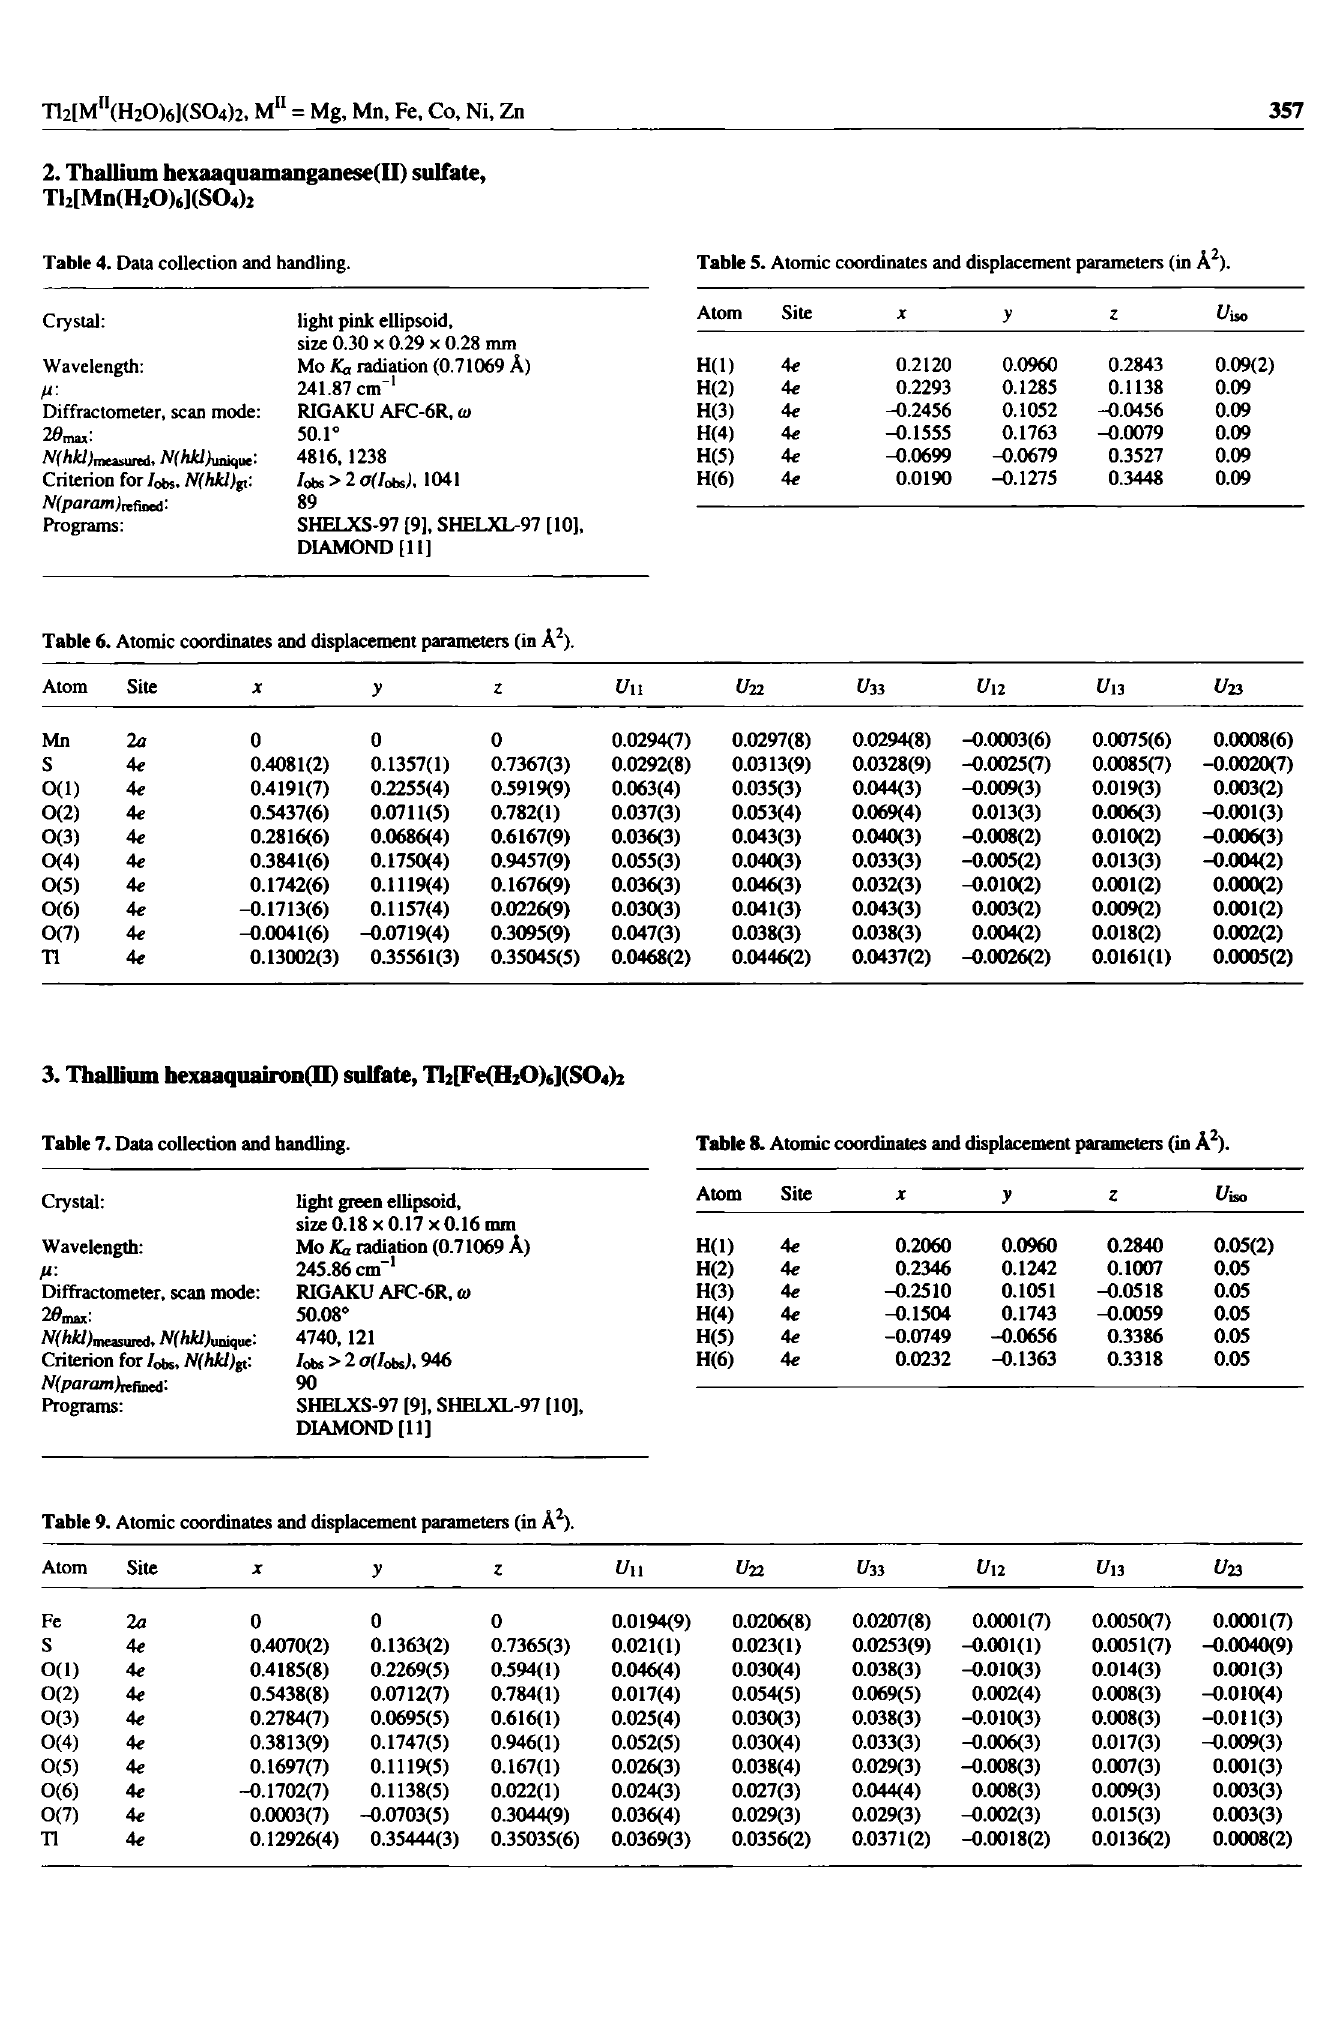
Table 9. Atomic coordinates and displacement parameters (in Â 2